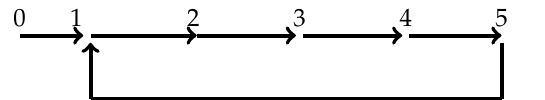
Figure 1. The topology of the